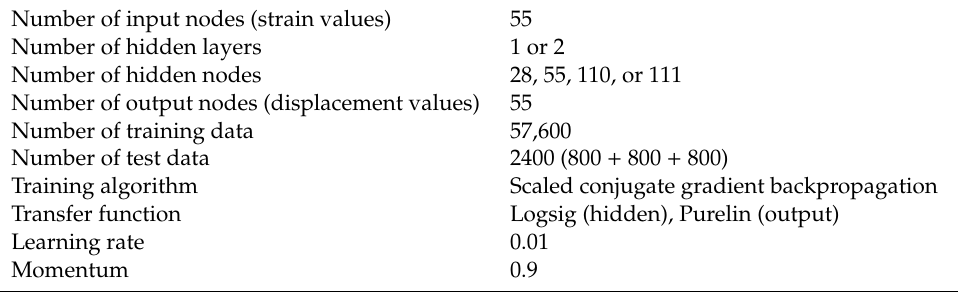
Table 4. General information for the artificial neural network (ANN)